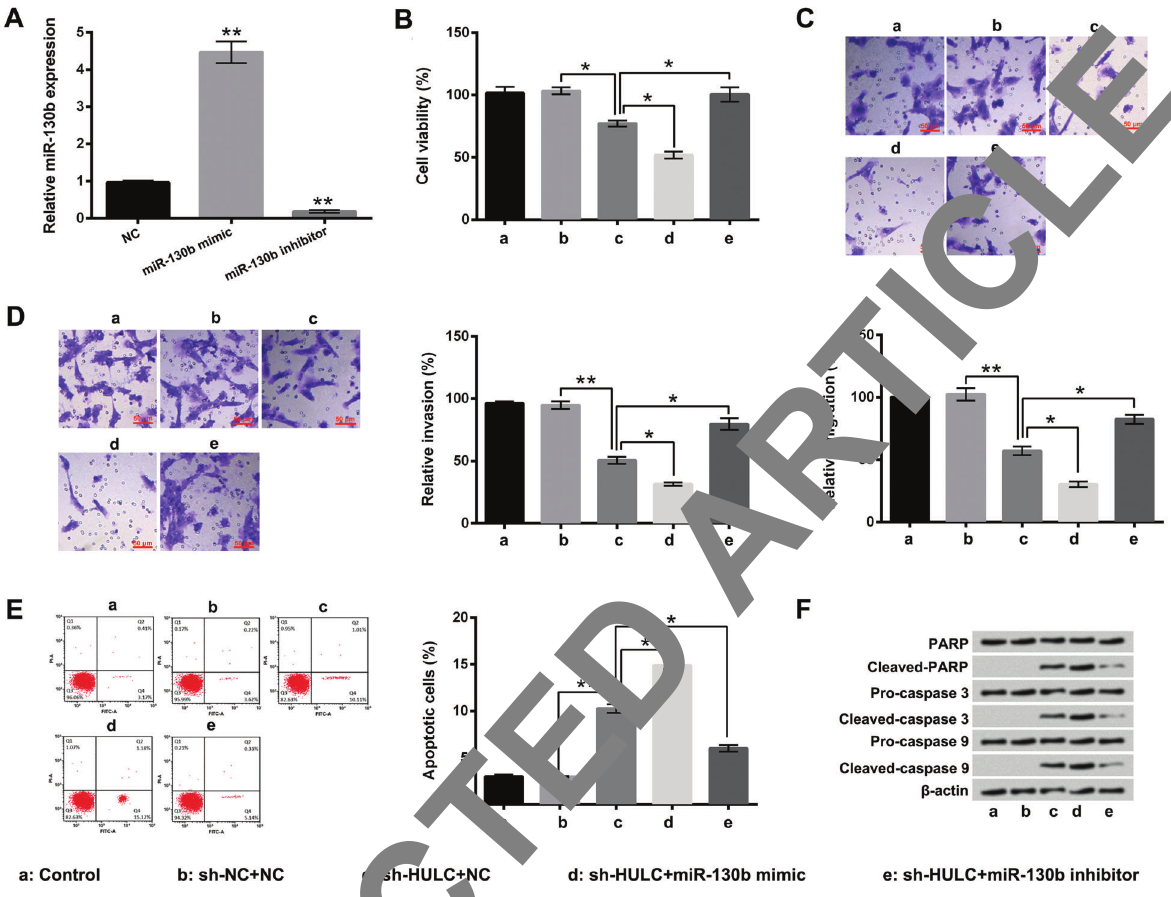
Figure 4. miR-130b participated in the effects of highly up-regulated in liver cancer (HULC) on GH3 cell viability, migration, invasion, and apoptosis. A , Expression of miR-130b in GH3 cells after miR-130b mimic or miR-130b inhibitor transfection was measured using qRT-PCR. After sh-HULC and/or miR-130b mimic (inhibitor) transfection, B – E , the viability, migration, invasion, and apoptosis of GH3 cells, and F , the expression levels of PARP, cleaved-PARP, pro-caspase 3, cleaved-caspase 3, pro-caspase 9, and cleaved-caspase 9 in GH3 cells were assessed using trypan blue staining assay, two-chamber transwell assay, Guava Nexin assay, and western blotting. miR-130b: microRNA- 130b; NC: negative control; PARP: poly ADP-ribose polymerase. Data are reported as means ± SD.*P o 0.05, **P o 0.01